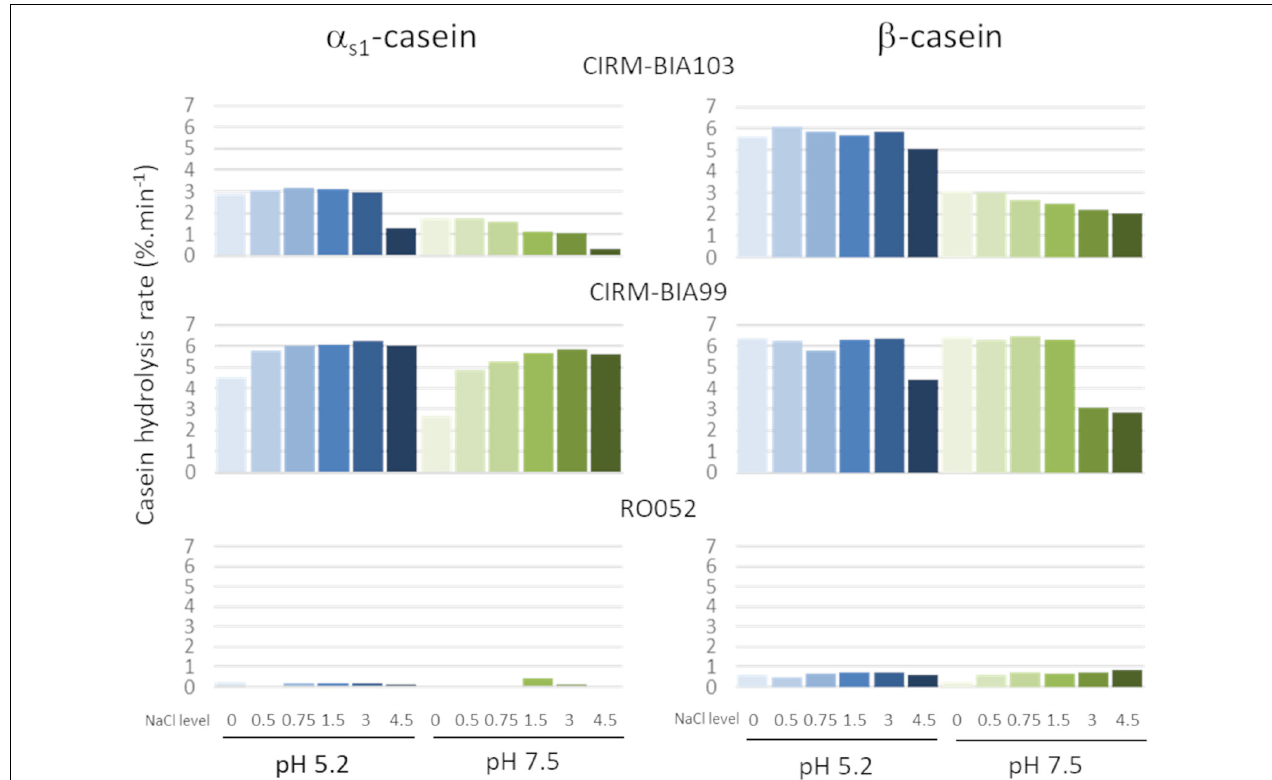
FIGURE 2 | Rate of α s1 - and β -caseins hydrolysis by three Lactobacillus helveticus strains possessing different CEP genes, at two pH (5.2, in blue and 7.5, in green) and six NaCl concentrations (0, 0.5, 0.75, 1.5, 3.0, and 4.5, from light color to dark color). Strains: L. helveticus CIRM-BIA103, CIRM-BIA99, and RO052.